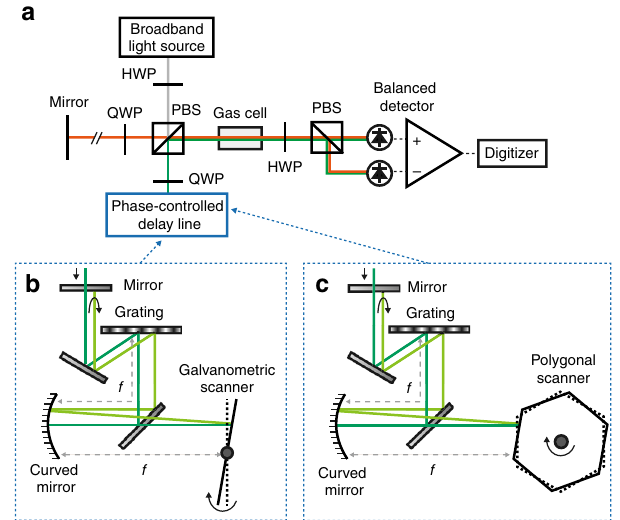
Fig. 2 Detailed schematic of the phase-controlled FTS. a Detailed schematic of PC-FTS. HWP Half-wave plate, QWP Quarter-wave plate, PBS Polarizing beamsplitter. b Phase-controlled delay line with a galvanometric